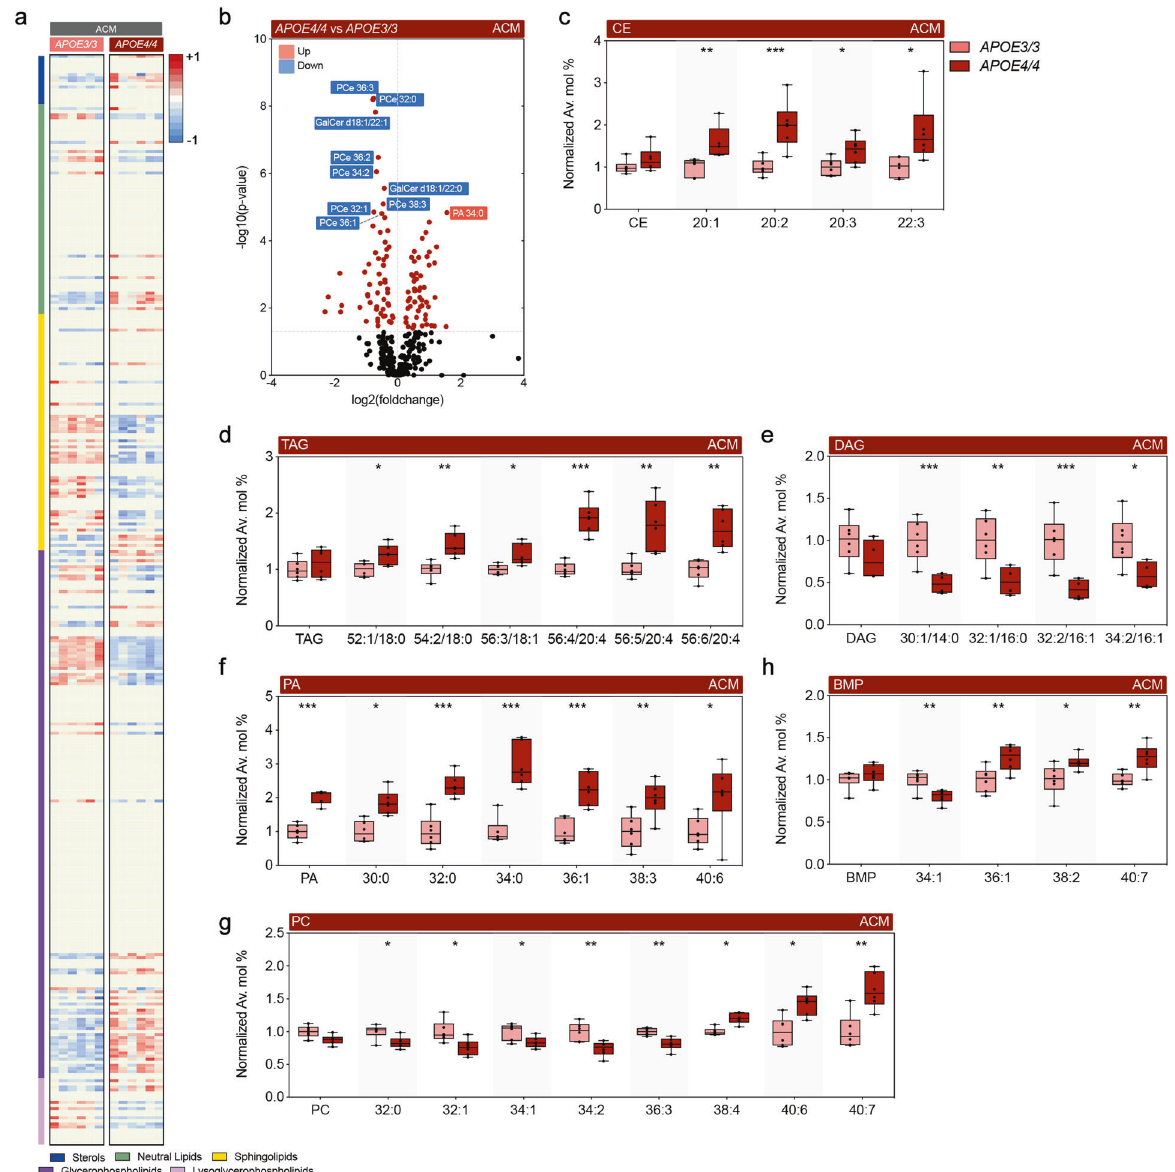
Fig. 3 Comparative effect of APOE 3/3 versus APOE 4/4 astrocyte conditioned media (ACM) on the lipid pro fi le of wild-type (WT) neurons. a Heatmap of lipids signi fi cantly altered in WT neurons after treatment with ACM derived from immortalized APOE3/3 and APOE4/4 astrocytes. Results expressed as Z-score [(average mol% of individual lipid species per genotype − average mol% of lipid in all genotypes)/standard deviation of average mol% lipid] represented in gradient color; blue and red indicate negative and positive Z-score, respectively. One-way ANOVA was performed and results threshold by p < 0.05; n = 6. b Volcano plots of differentially modulated lipid species under same conditions as in ( a ). Colored plots denote signi fi cant alterations (Tukey ’ s post-hoc p < 0.05), black plots denote unaltered species ( p > 0.05). c – h Normalized average mol% (fold-change) of ( c ) CE, ( d ) TAG, ( e ) DAG, ( f ) PA ( g ) PC, ( h ) BMP lipid species from WT neurons incubated with ACM. Lipids were annotated per total acyl carbons and degree of unsaturation. Data represent median ± max/min. One-way ANOVA followed by Tukey ’ s post-hoc test for multiple comparisons was performed. * p < 0.05, ** p < 0.01, and *** p <